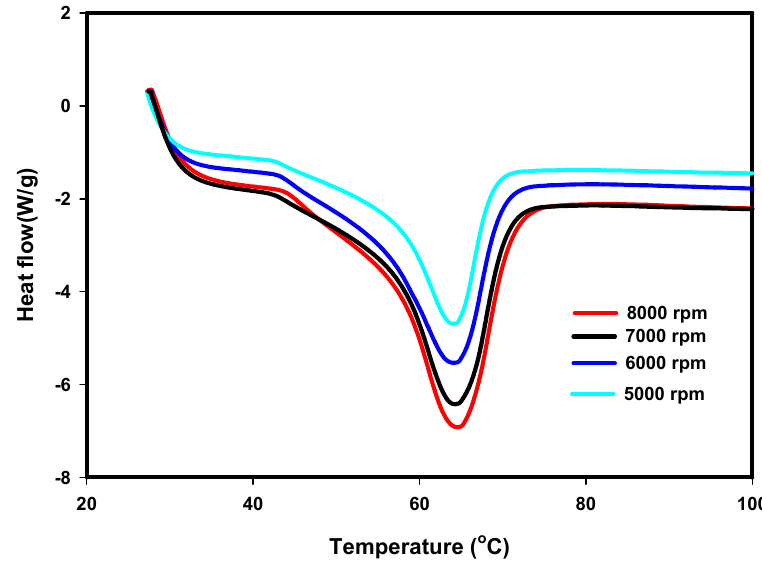
Figure 12. Melting endotherm of PCL fibers prepared by the FS of 12.5 wt% PCL solutions in DMF:THF (40:60 by volume) mixture at different rotational speeds.